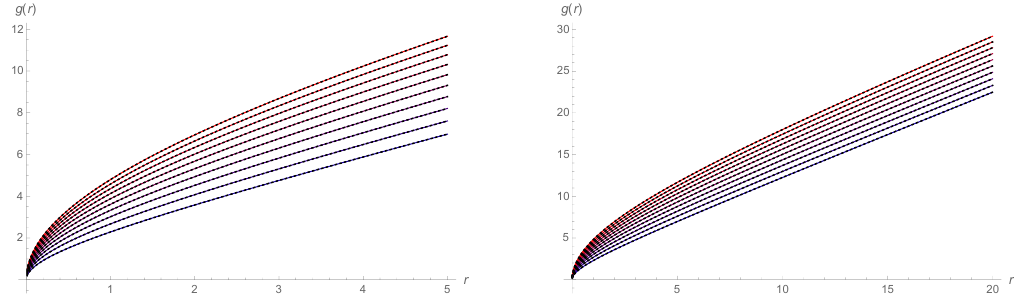
Figure 14 . Comparison between g , for A = 1 (blue) to A = 10 (red), to g 0 f app (dotted). We consider the ranges: a) 0 (cid:20) r (cid:20) 5 and b) 0 (cid:20) r (cid:20)